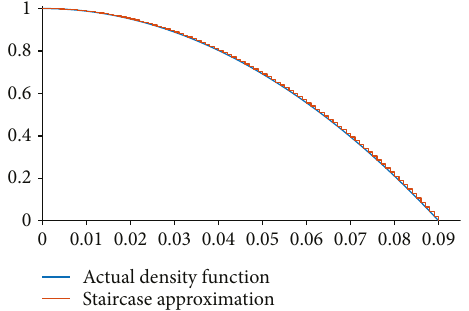
Figure 22: Comparison between the actual inhomogeneous density function for the plasmas considered herein and its staircase approximation in the FDTD